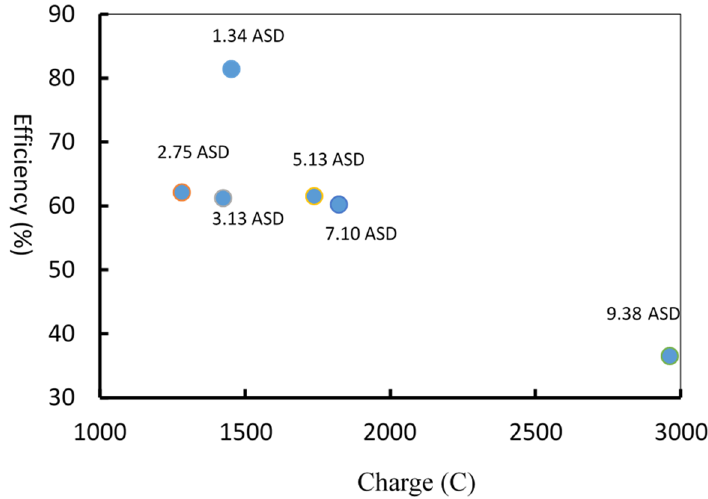
Figure 8. Plot of anodization efficiency related to charge with various current